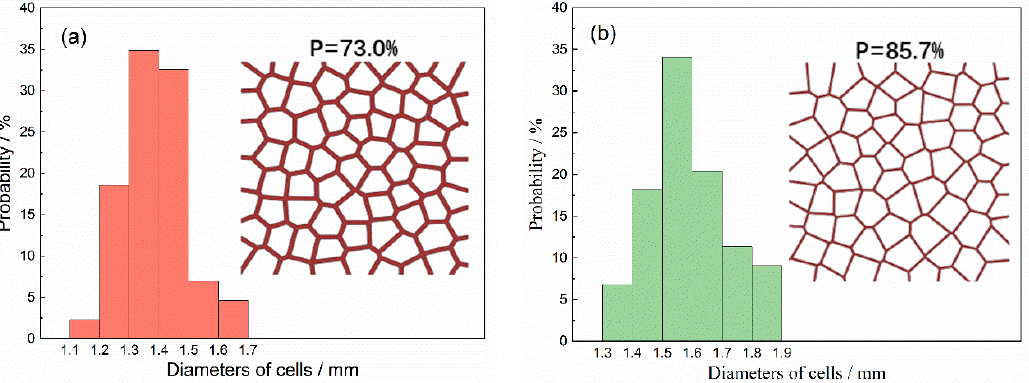
Figure 2. Two-dimensional Voronoi foam specimens with different porosities and their cell size dis- tributions ( a ) 73.0%, ( b ) 85.7%.